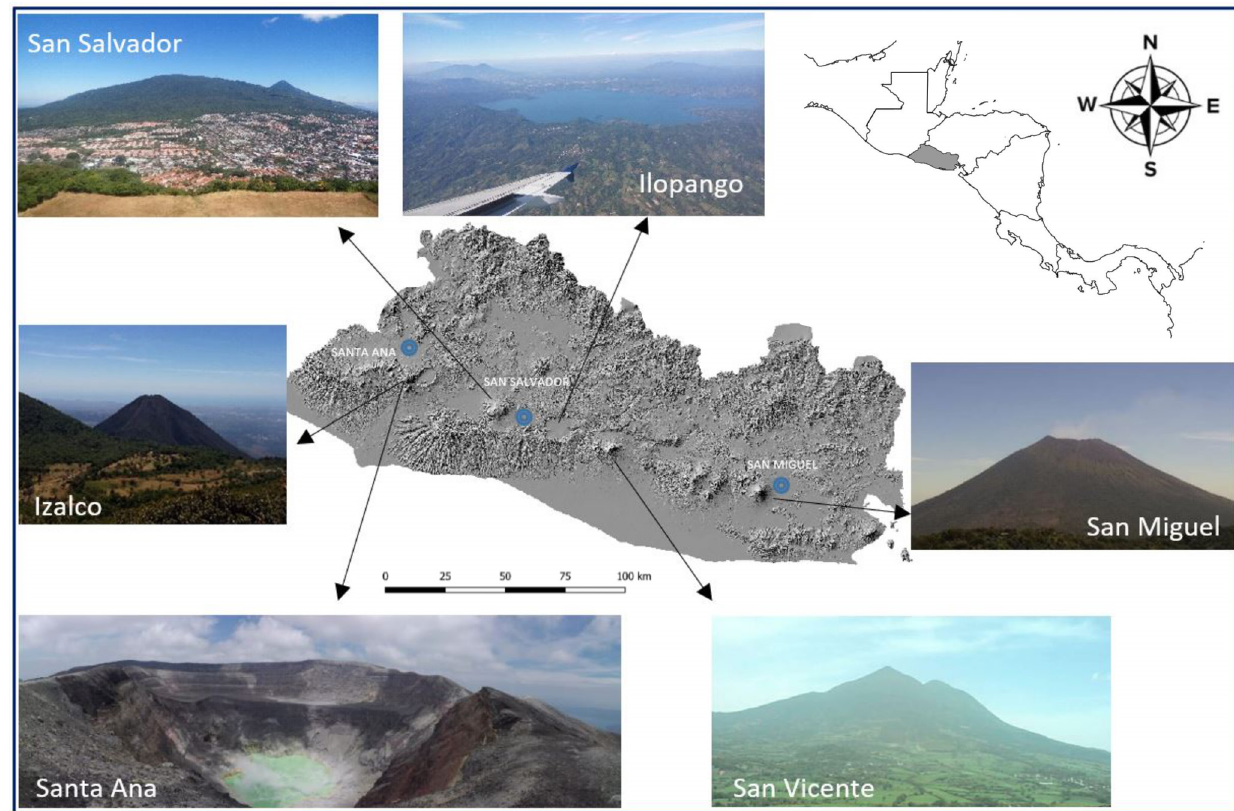
Figure 1: Location of the six monitored actives volcanoes of El Salvador and location of the main cities. The Background is a hillshade map by MARN [2019a]. Images of Ilopango Caldera (December 2016), San Salvador volcano (November 2017), Izalco volcano (February 2016) and Santa Ana volcano (March 2018) by R. Castro. Image of San Vicente volcano (July 2018) by M.A. Serra; and the image of San Miguel volcano taken by the web- cam owned by MARN in February